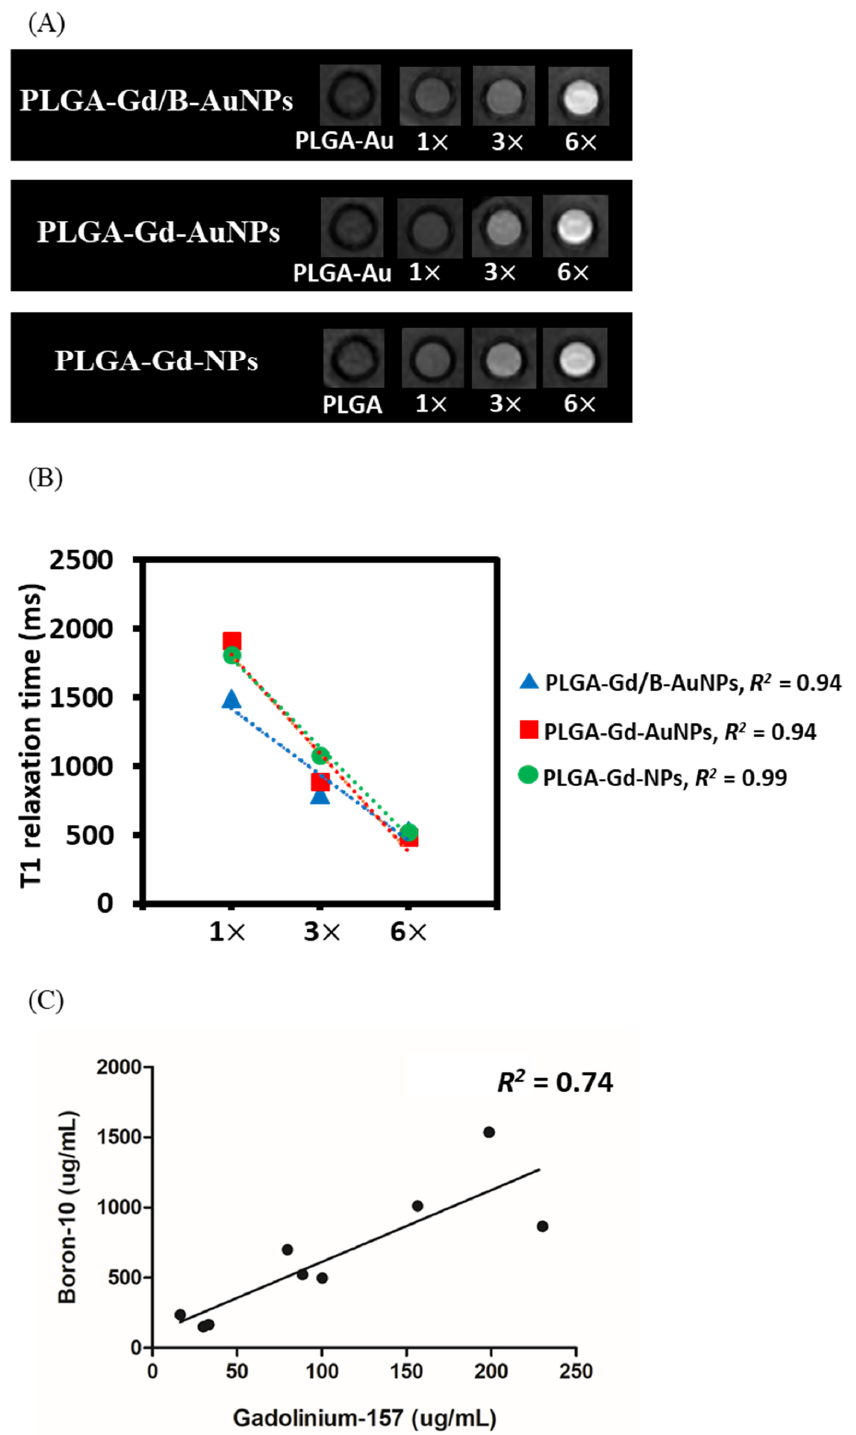
Gd concentrations (Figure 3C, R 2 = 0.74, p < 0.005). As the Gd concentration has a positive effect on MRI signals (Figure 3A), the tight relationship between B and Gd concentrations may imply that B concentration can be noninvasively evaluated by the MRI signal.